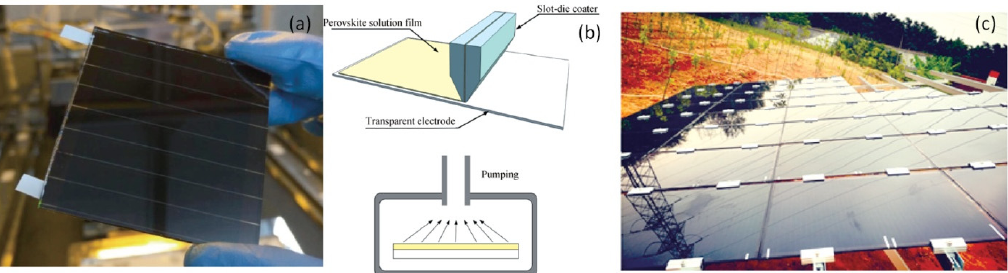
Figure 25. ( a ) The 5 × 5 cm 2 module is scribed by a laser into 8 strips, forming 7 individual cells connected in series. ( b ) Slot-die coating and pumping of perovskite liquid film and ( c ) the demonstration power plant, comprising large modules of 45 × 65 cm 2 [102]. (Reproduced from Ref. [102], 10.1088/1674-4926/38/1/014006, with